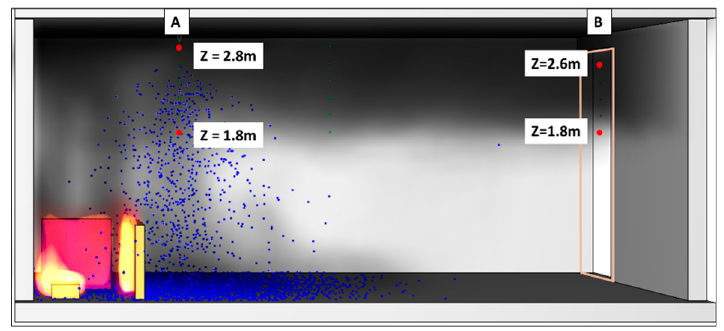
Figure 9. The location of numerical devices to investigate smoke spread in the compartment.